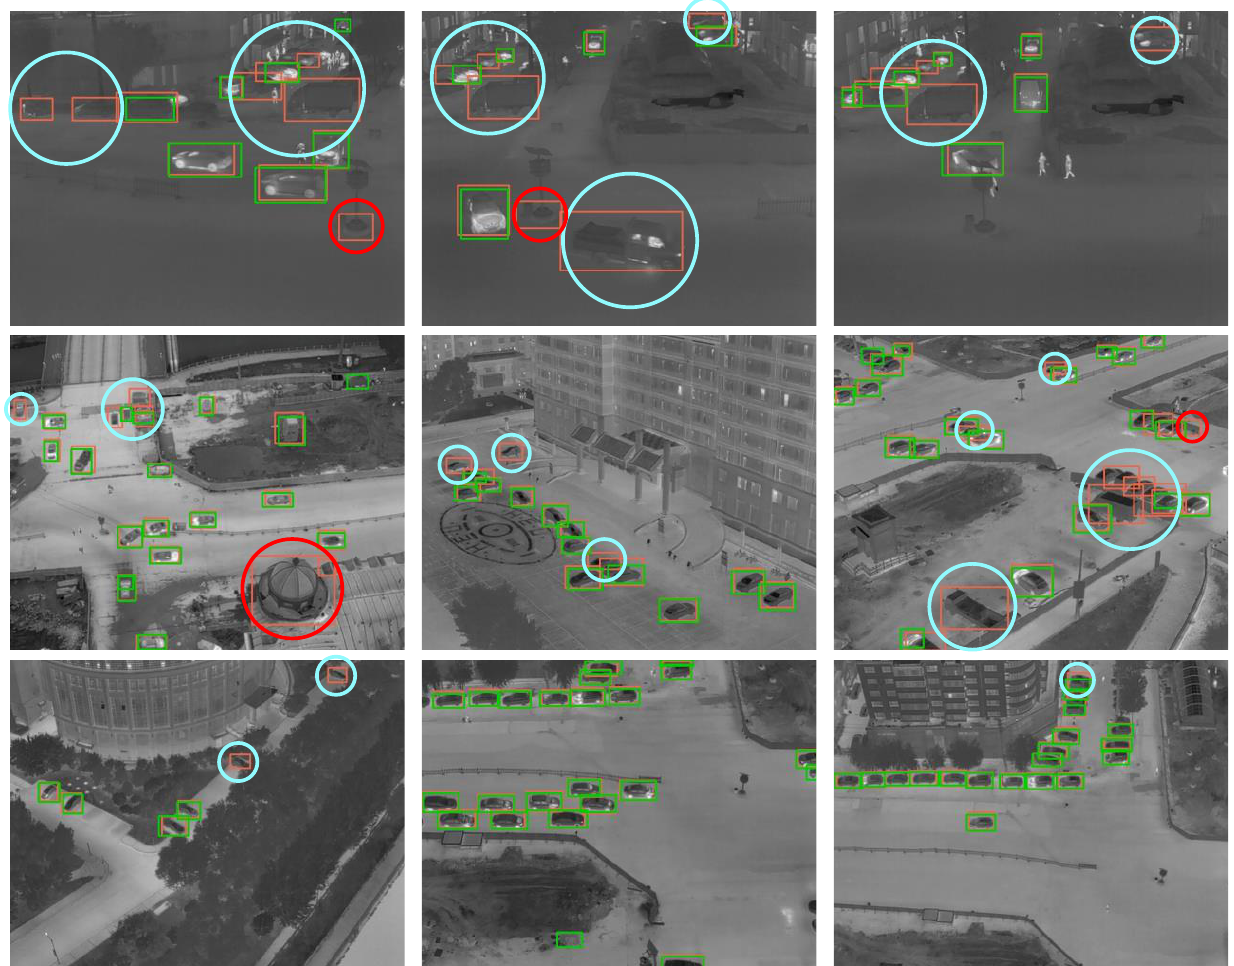
Figure 9. Our method detects results on some typical images in remote sensing datasets. The prediction box of the baseline is marked as green, and the prediction box of the proposed method is marked as yellow.